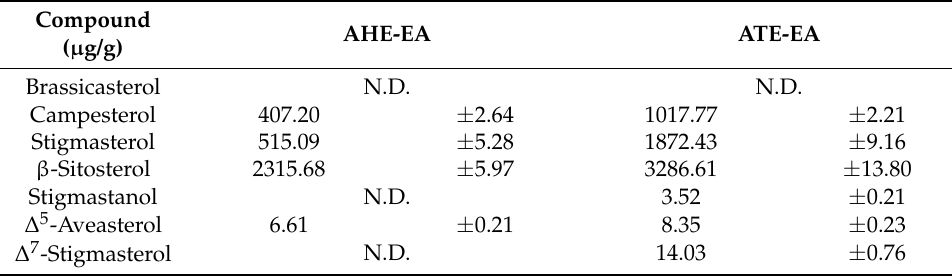
Table 6. Chemical composition analysis of phytosterol of ATE-EA and AHE-EA by